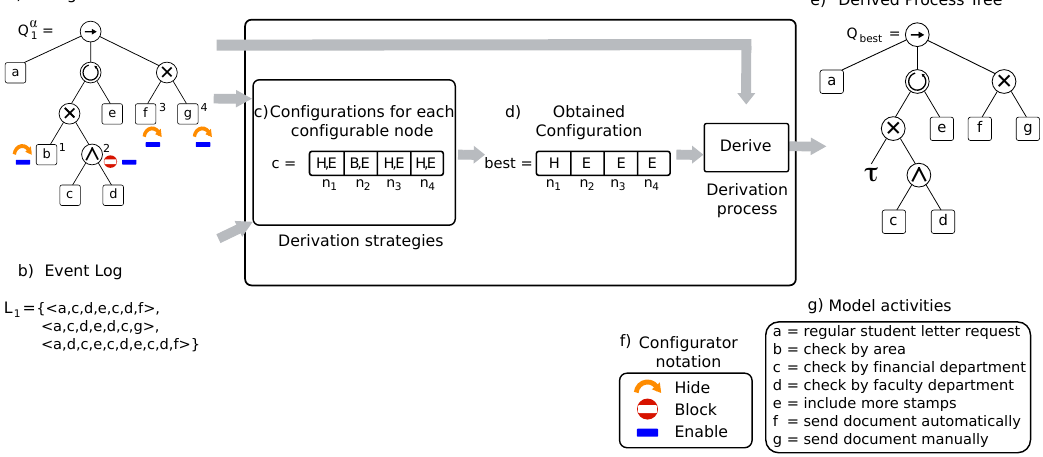
Figure 5. Running example that illustrates the derivation framework. A configurable process tree and and event log, shown in ( a ) and ( b ), are the inputs. The internal representation of a configuration used by the three strategies is represented in ( c ). The obtained configuration is shown in ( d ). Finally, the output, a derived process tree, is shown in ( e